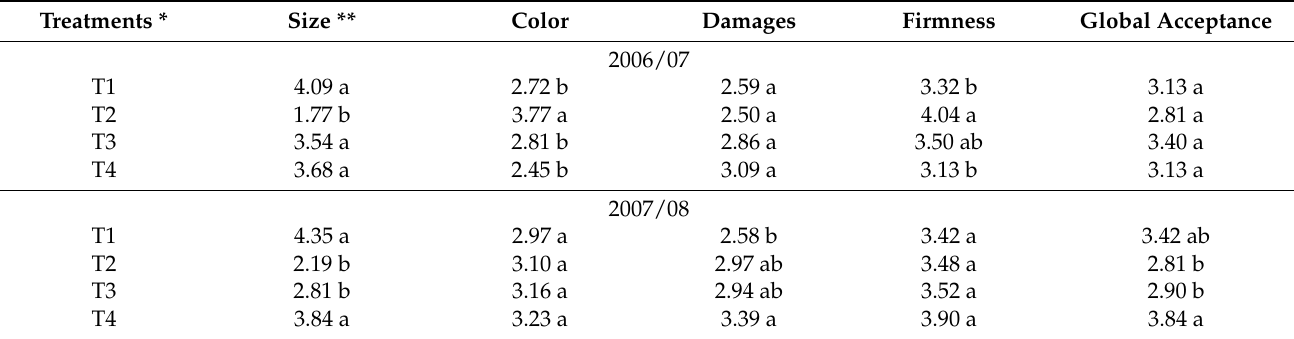
Table 6. Effects of deficit irrigation treatments on external attributes scored by a sensory evaluation panel. Treatments * Color Damages Firmness